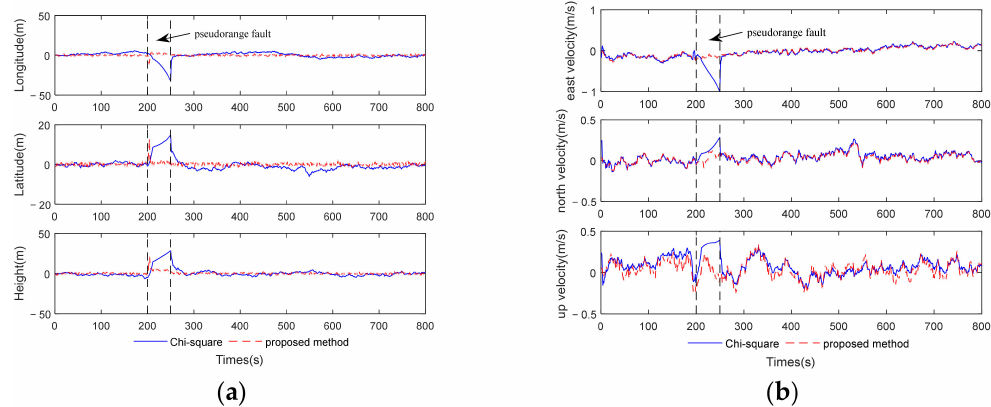
Figure 9. The fusion states’ errors under the single-satellite ramp fault: ( a ) position errors; ( b ) velocity errors.